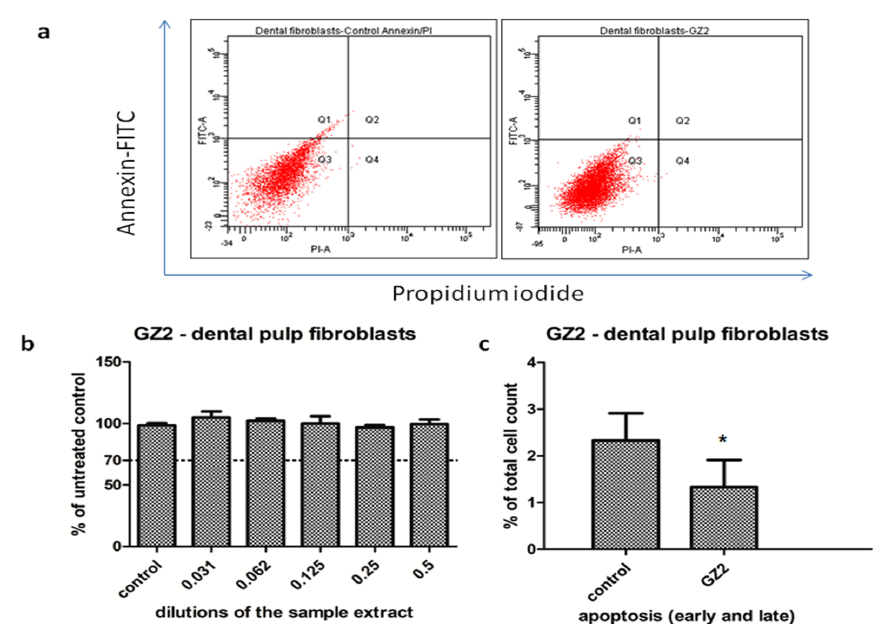
Figure 2. Cell viability and flow cytometry analysis of dental pulp stem cells exposed to GZ2 restorative composite. ( a ) Comparative flow cytometry diagrams of dental pulp stem cells untreated (left panel) and treated with GZ2, 0.5 extract dilution (right panel), following annexin-FITC / PI staining. The viable cells (showing no apoptosis) were identified as Annexin V (-) / PI (-). The apoptotic cells were identified as Annexin V (+)/PI (-) (early apoptosis), and Annexin V (+)/PI (+) (late apoptosis). The differentiation among these three-cell-type populations was made by flow cytometric detection.